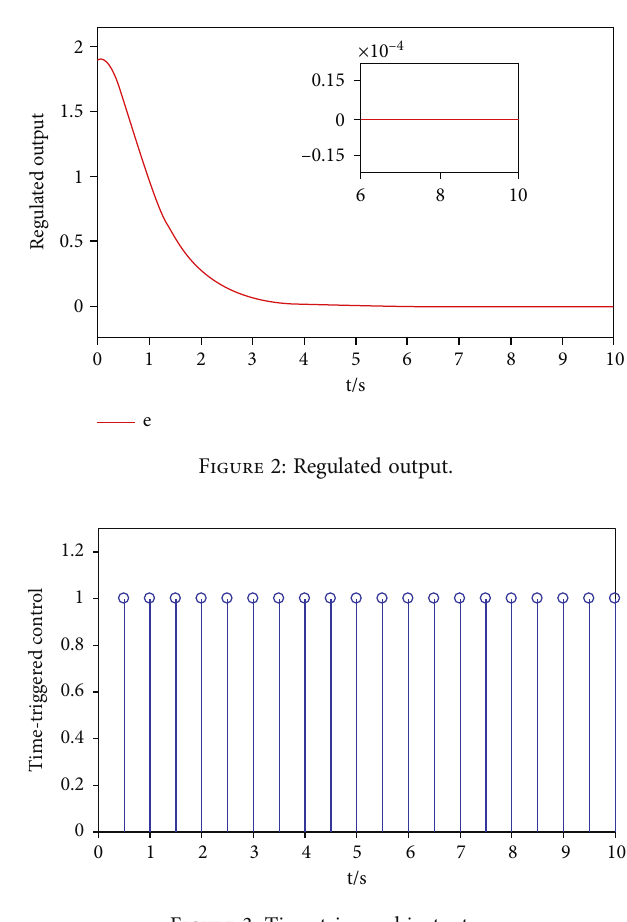
Figure 3: Time-triggered